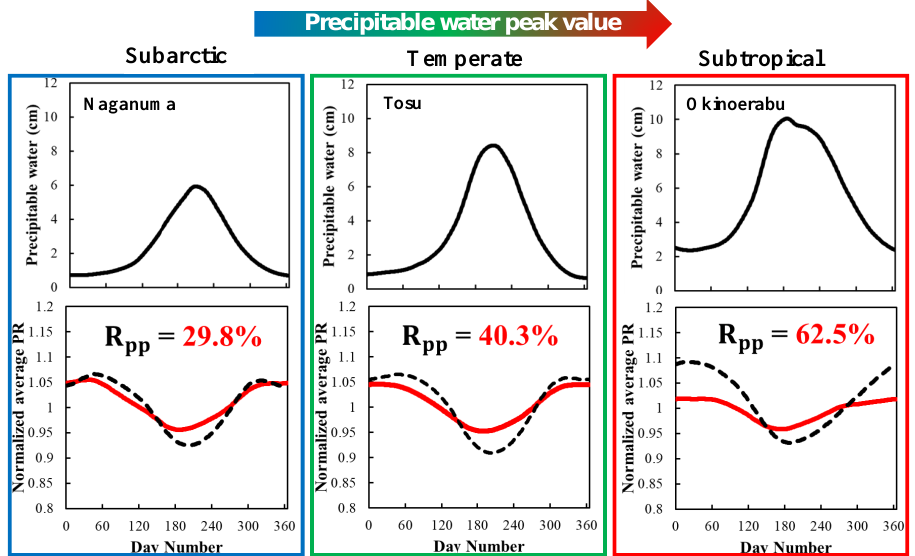
Figure 8. Comparison of the annual output between 4T configuration and 2T configuration a ff ected by the variation of the atmospheric parameter. The red solid trend line in the bottom charts corresponds to